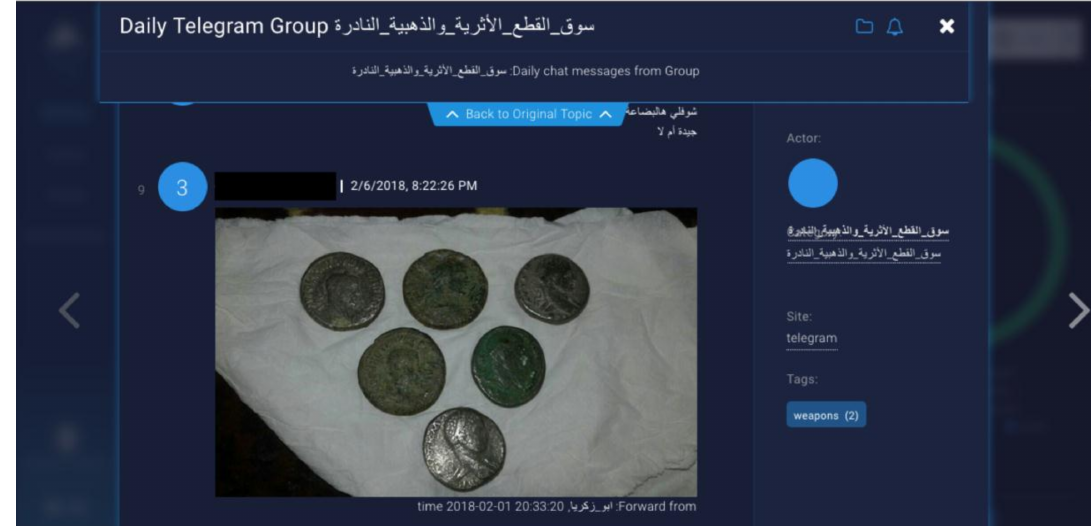
Figure 6. Screen grab of Sixgill platform search that turned up ancient coins illicitly offered for sale through a jihadi Telegram communication group. Phone number of offending individual has been redacted for the purposes of this paper. (Screen grab by author 2018).